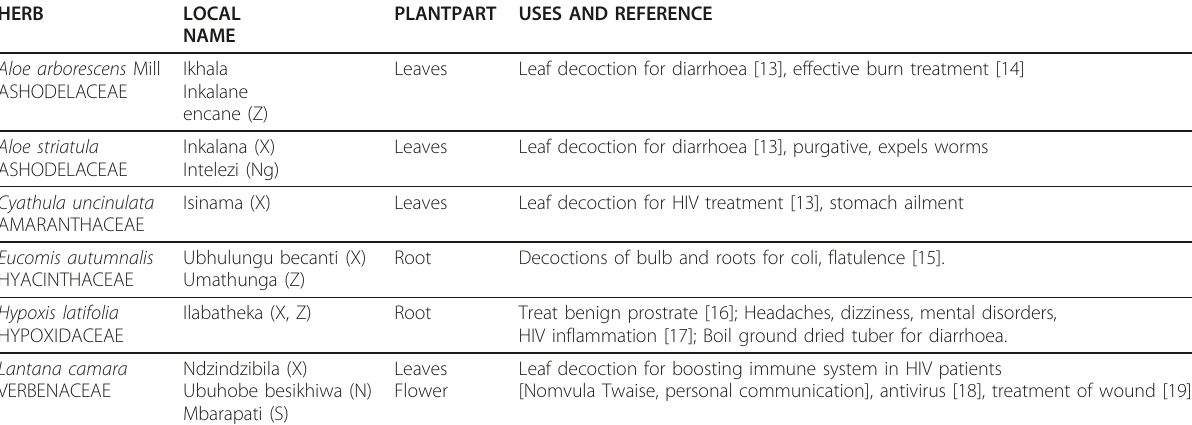
Table 1 Selected plants investigated and their usage